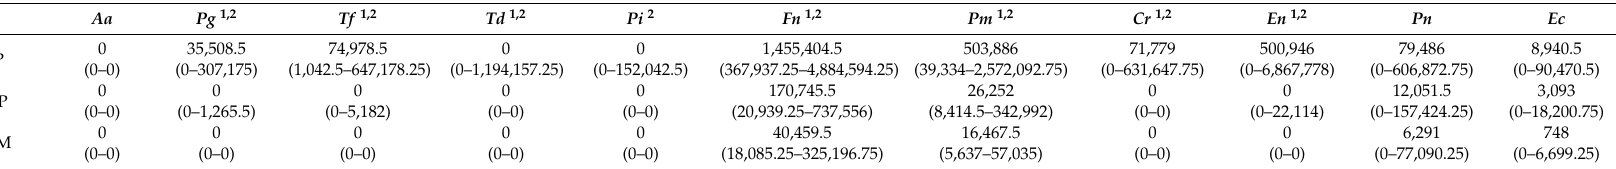
Table A2. Bacterial DNA counts of target bacteria in gingival retraction cord samples of di ff erent study groups. Median values and interquartile ranges were summarized in the